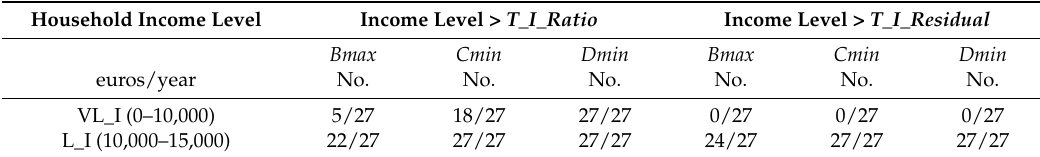
Figure 8. T_I_ratio ( a ) and T_I_residual ( b ) in euros/year ( y -axis) per zone and per municipality of the metropolitan area of Palermo (NWS area). Table 6. Frequency of housing affordability per income level and per zone in the NWS